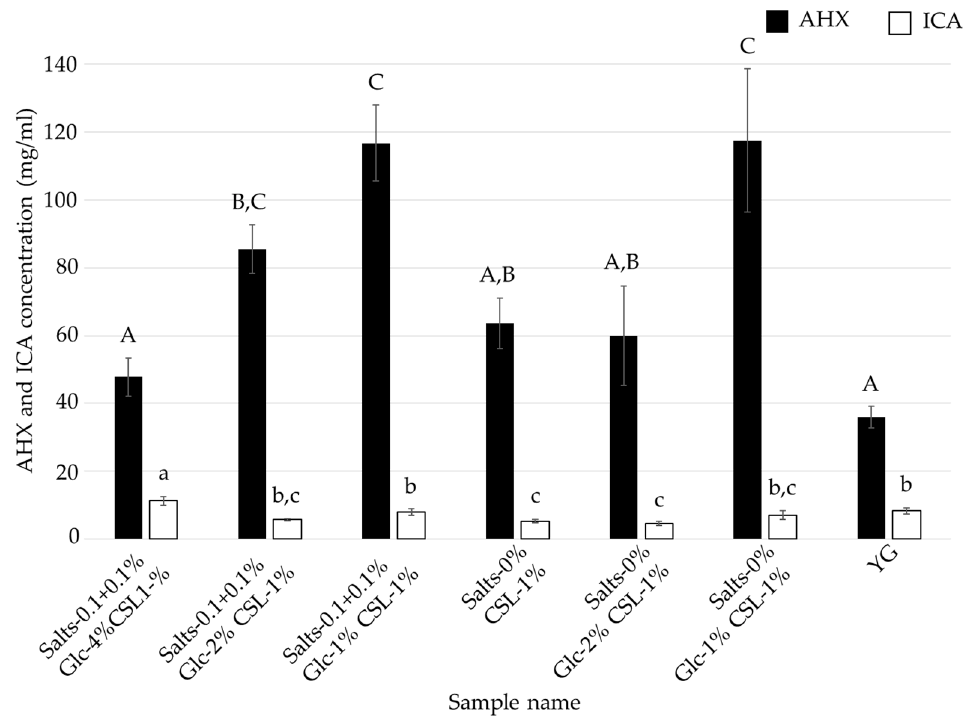
Figure 6. AHX and ICA contents of the culture filtrates of L. sordida mycelia cultured in CSL-1% media with reduced concentrations of glucose and inorganic salts. Different alphabet letters (capital letters for AHX, and small letters for ICA) indicate significant differences (Tukey–Kramer post hoc test, p < 0.05; n = 3).